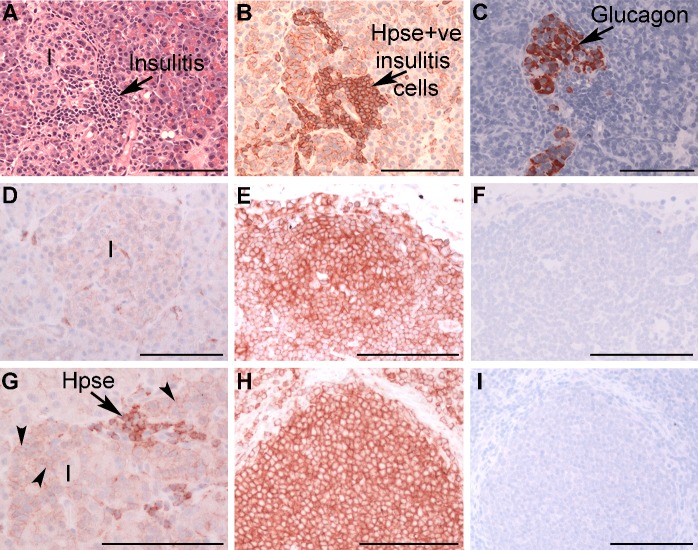
Heparanase is expressed by human insulitis leukocytes.(A) An islet (I) with insulitis in nPOD pancreas #6084 (4 years post-T1D onset) shows (B) leukocytes strongly expressing heparanase (Hpse) and (C) glucagon staining. Normal human islet cells (nPOD #6012) (D) showed negligible heparanase expression compared to pancreatic lymph node (PLN) from the same donor (E). Islet cells in Ins+ T1D pancreas (nPOD #6070) weakly expressed heparanase (arrowhead), compared to nearby infiltrating leukocytes (arrow) (G) and host PLN (H). Background staining with isotype control Ig was absent in PLNs (F and I). (A) H&E; (B, D, E, G, H) anti-Hpse HP130 mAb; (C) anti-glucagon mAb; (F, I) mouse IgM. Scale bar = 100 μm.